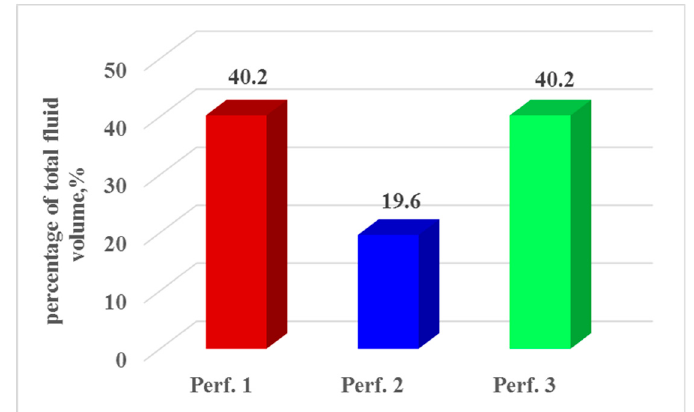
Figure 3. Percentage of total flow volume entering into each perforation cluster.